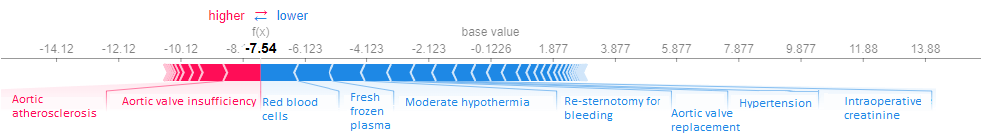
Figure 2. Feature importance diagrams for target variables: ( a ) in ‐ hospital mortality; ( b ) TND; ( c ) PND; ( d ) prolonged lung ventilation; ( e ) RRT; ( f ) MOF; ( g ) MI.